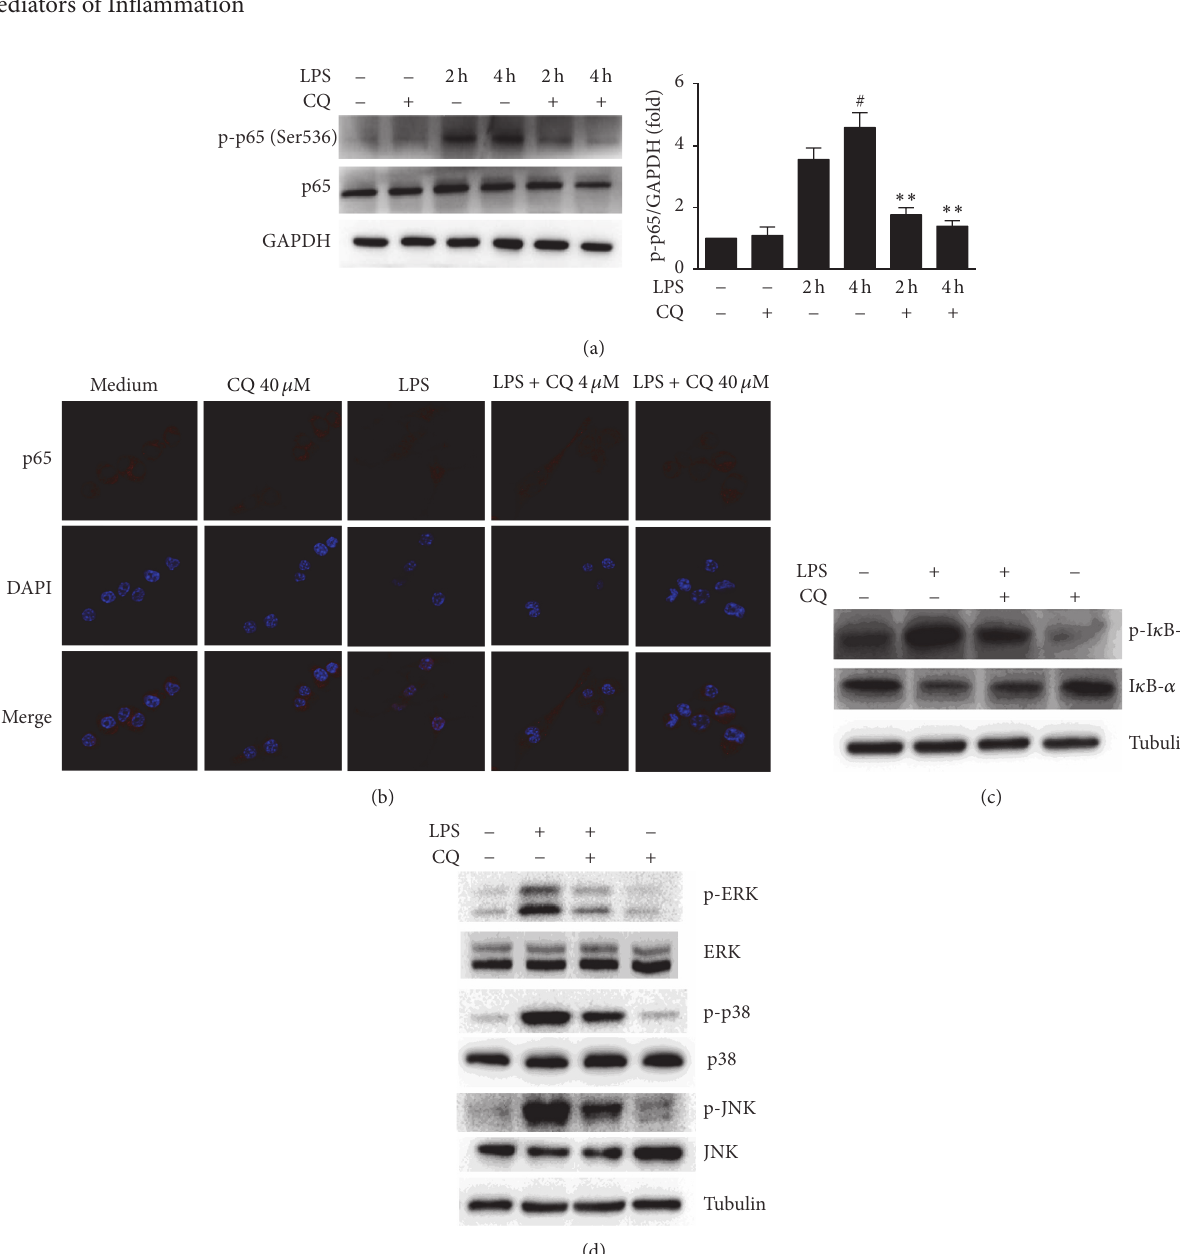
Figure 3: CQ restrains NF- 𝜅 B p65 phosphorylation and nuclear localization. (a) Western blot of phospho-NF- 𝜅 B p65 (Ser536). Cells were pretreated with 40 𝜇 M CQ for 1h and then 100ng/ml LPS treated for 2 h and 4 h, respectively. Total cell protein was collected for western blot of NF- 𝜅 B p65 phosphorylation and GAPDH. # 𝑃 < 0.05 versus LPS group (2h). ∗∗ 𝑃 < 0.01 versus LPS group (4 h). (b) Cells were pretreated with 40 𝜇 M CQ for 1h and then stimulated by LPS for 30 min. I 𝜅 B- 𝛼 and phospho-I 𝜅 B- 𝛼 levels were detected by western blot. (c) Confocal images of nuclear translocation of NF- 𝜅 B p65. Cells were pretreated with different concentrations of CQ for 1h, followed by 100ng/ml LPS treatment for 2 h. Cells were stained by anti-NF- 𝜅 B p65 (red) antibodies and DAPI (blue) for nuclear staining. (d) Cells were treated as in (b). ERK, p38, and JNK and their phosphorylated forms (p-I 𝜅 B- 𝛼 , p-ERK, p-p38, and p-JNK) in cell lysates were detected by western